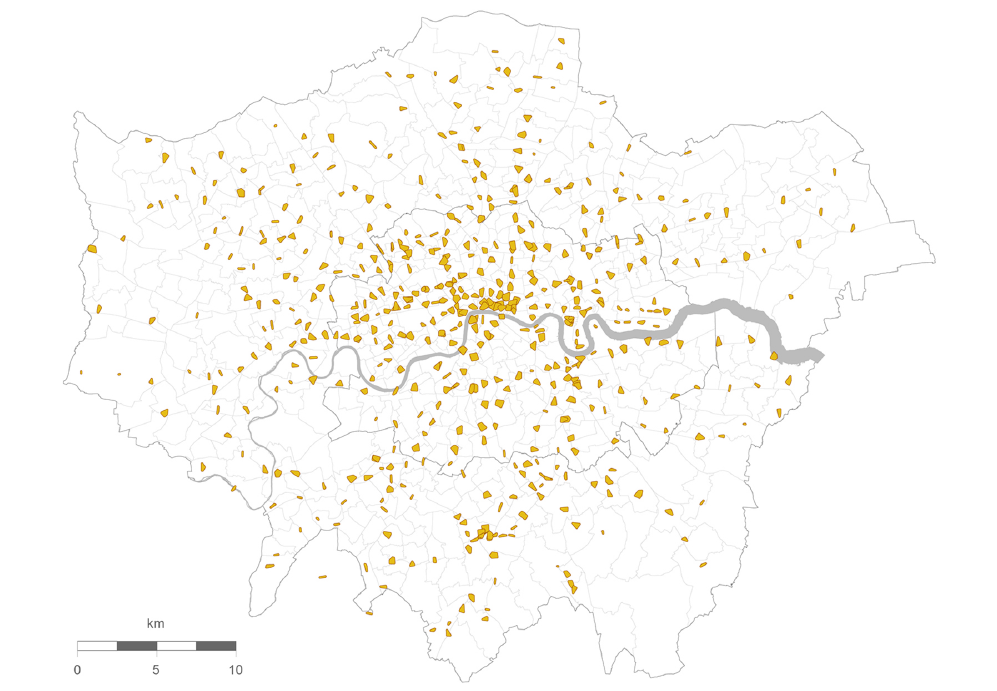
Figure 2: Spatial units of research across